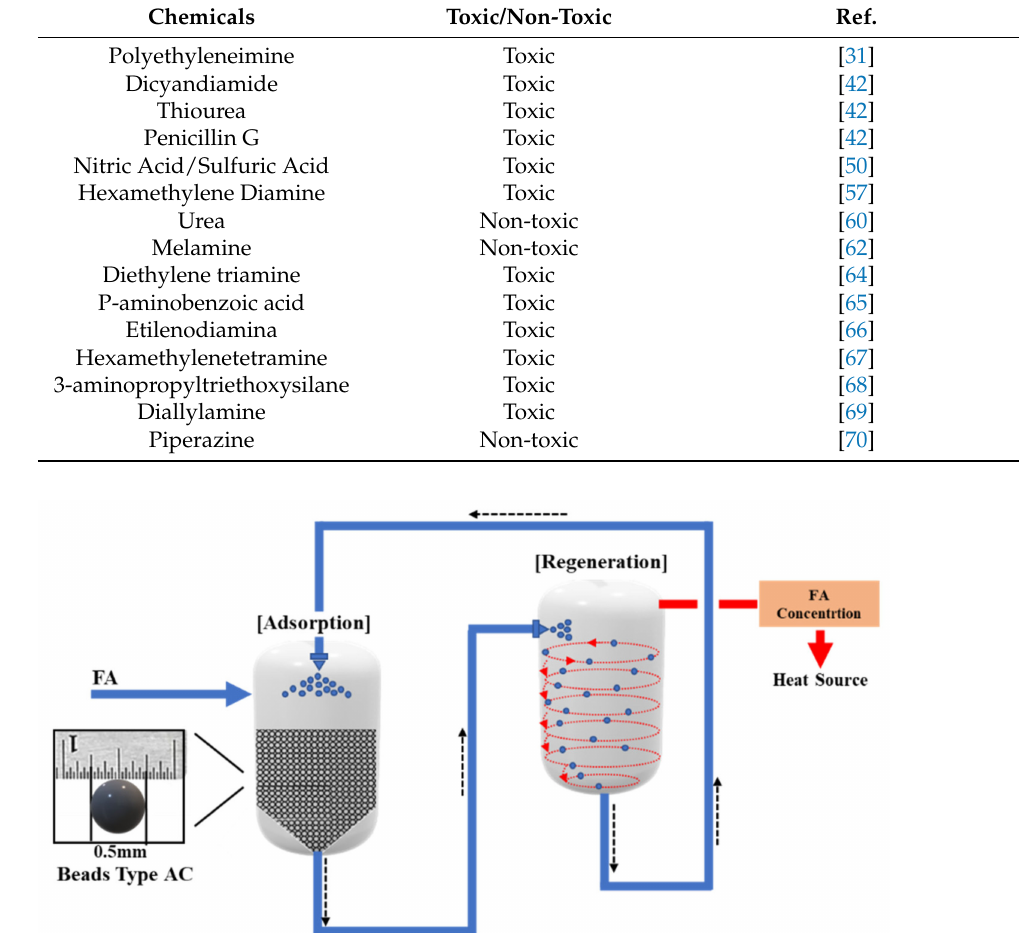
Table 5. Amine sources based on toxic/non-toxic chemicals.